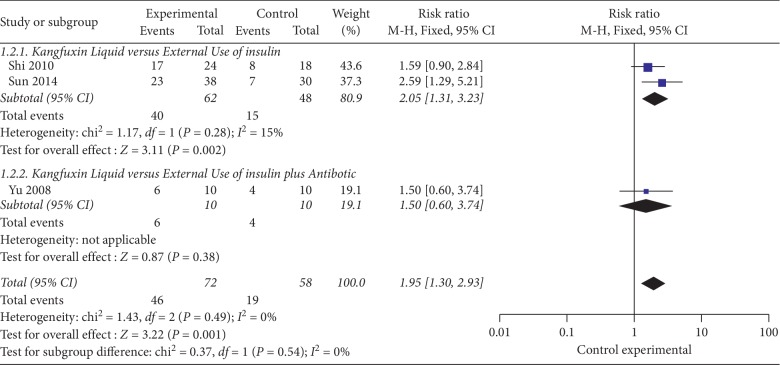
The total effective rate KFXL versus external use of pharmaceutical medications based on same basic treatment.